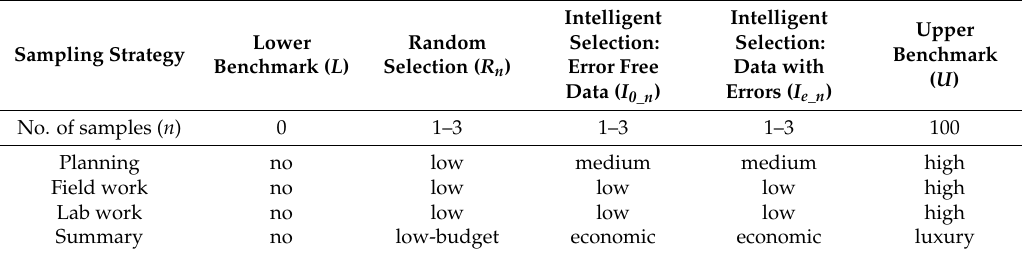
Table 3. Comparison of the different sampling